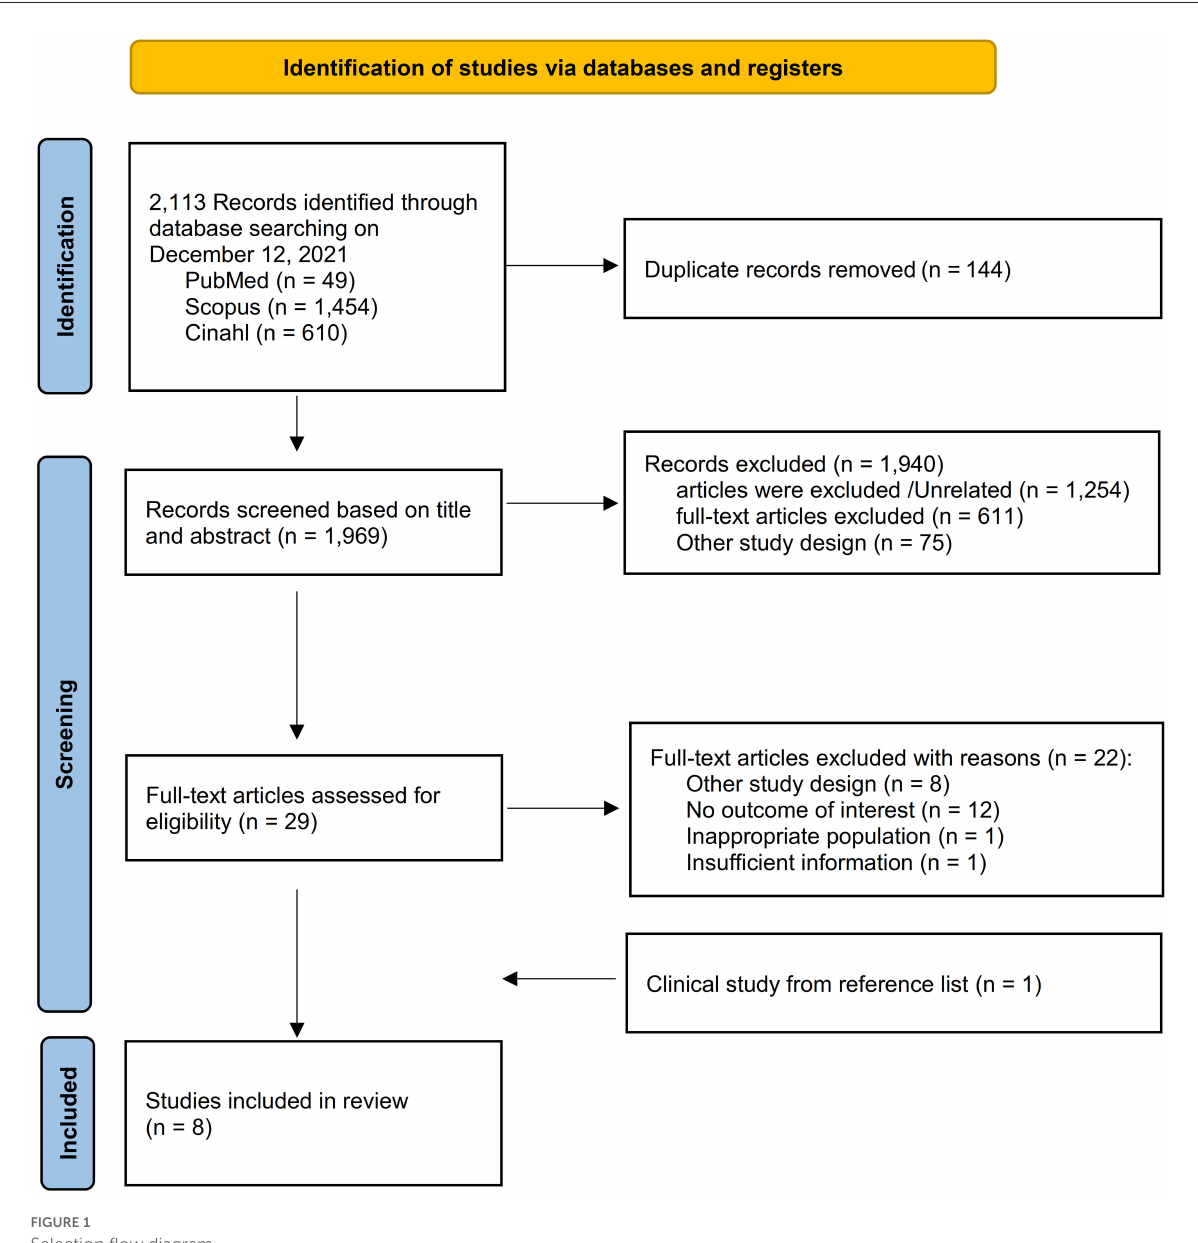
FIGURE1 Selection flow